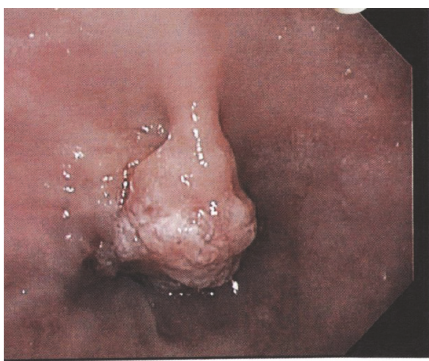
Figure 1: Esophageal tumor seen during EGD.